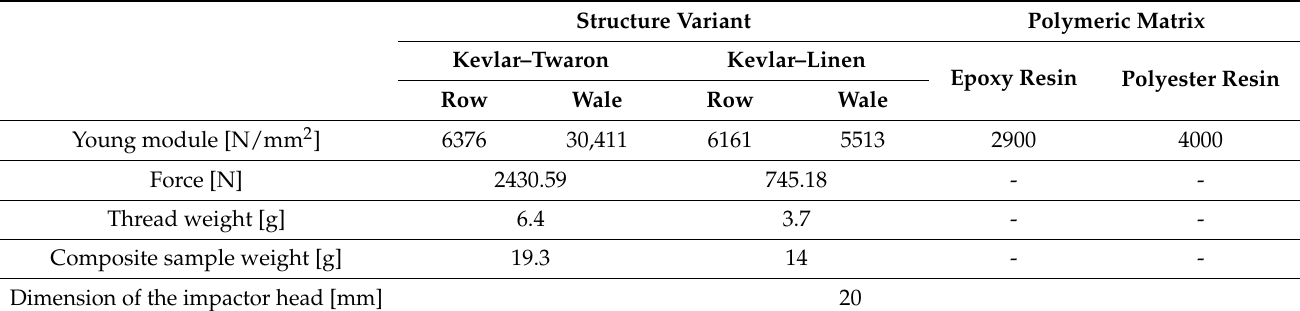
Table 2. Physical mechanical characteristics of composite materials.